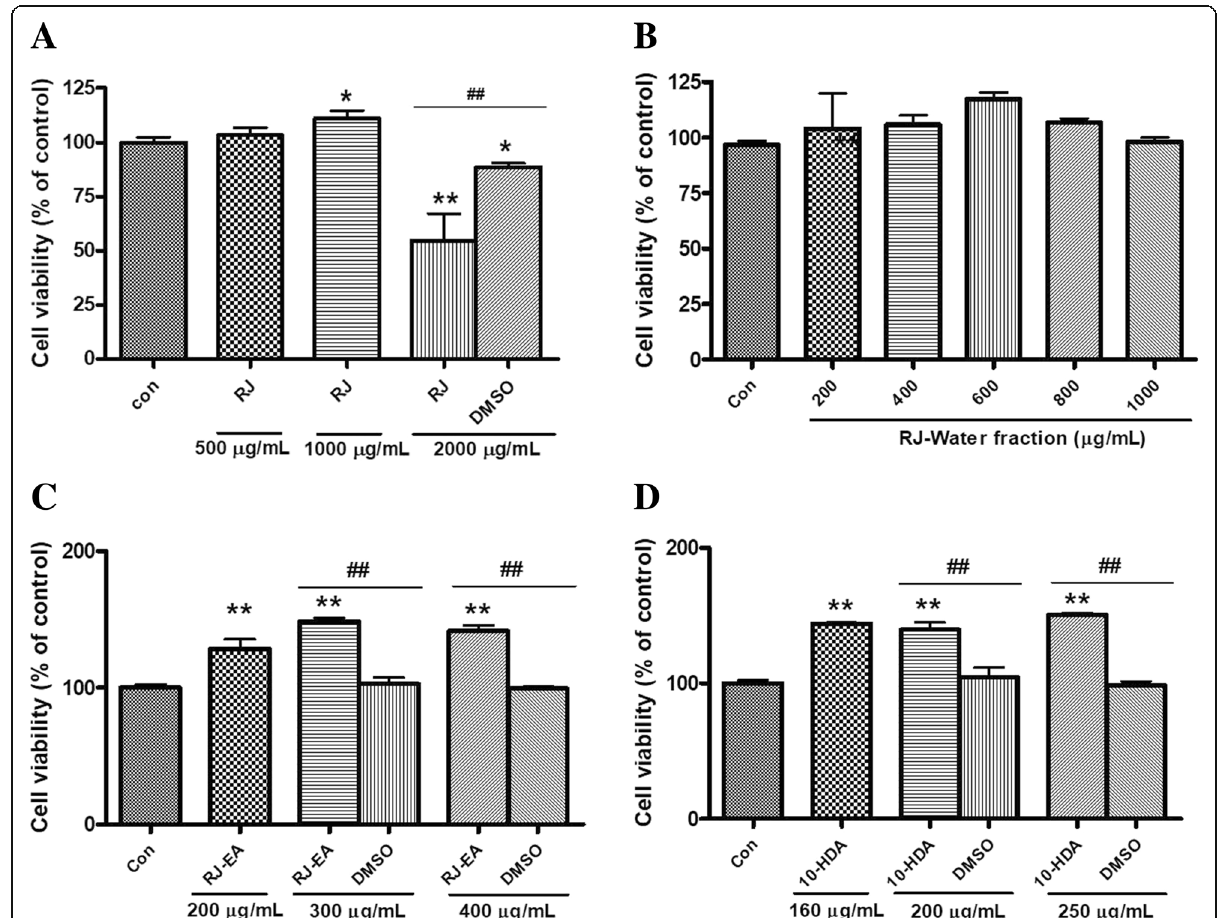
Fig. 2 Effect of ( a ) royal jelly (RJ), ( b ) royal jelly-water fraction, ( c ) royal jelly-ethyl acetate (RJ-EA) fraction, and ( d ) 10-HDA compound on the cell viability of 3 T3-L1 preadipocytes. Data are presented as percentage viability of preadipocytes compared with untreated control. The data shown are presented as means ± SD of triplicate experiments. Statistical significance was calculated using one-way ANOVA followed by Dunnett ’ s multiple comparisons test. * P < 0.05 vs control; ** P < 0.01 vs control. Statistical significant difference between any particular sample concentration and equivalent DMSO amount of that concentration was calculated using unpaired two-tailed Student ’ s t-test. ## P < 0.01indicates